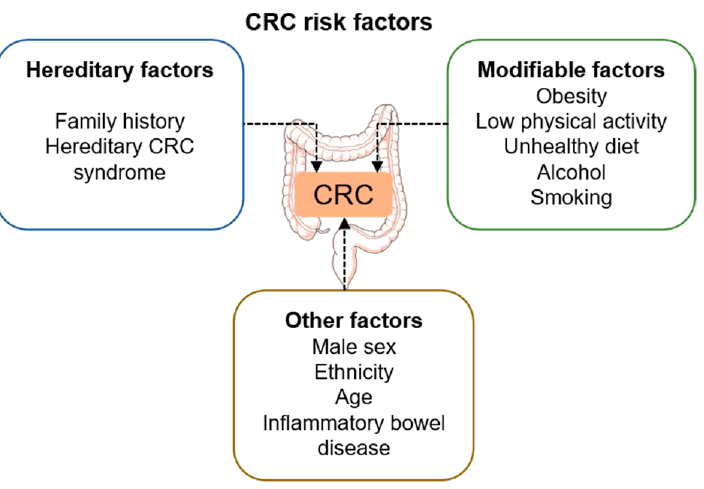
Figure 1. Overview of the main risk factors associated with CRC development.